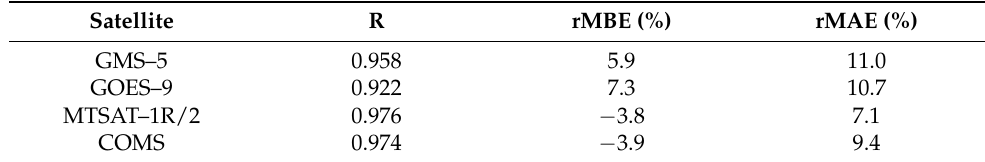
Table 4. Error statistics of satellite estimates for each satellite.